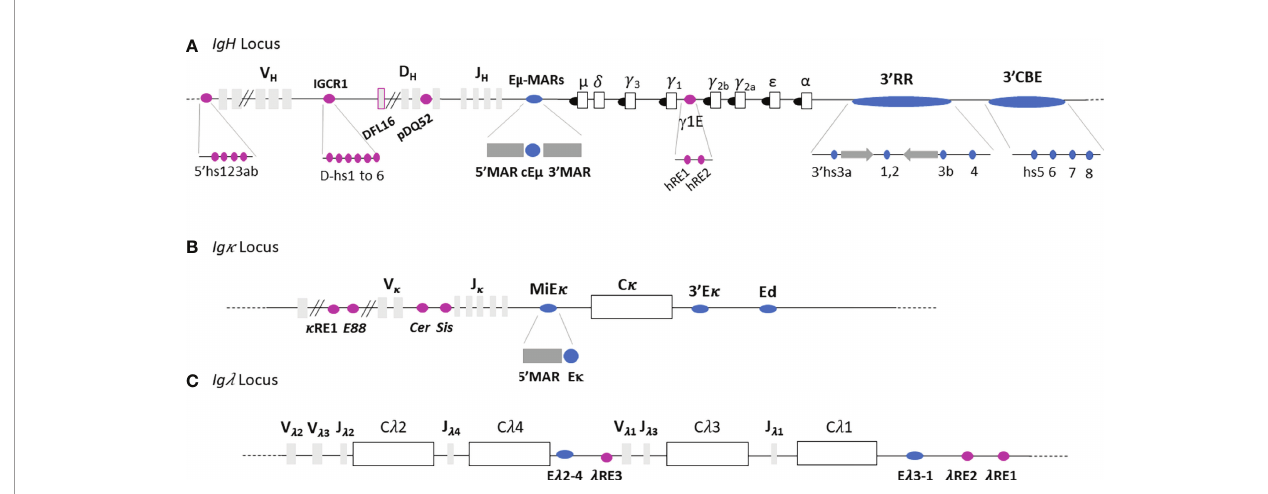
FIGURE 2 | Immunoglobulin loci. (A) IgH locus. (B) Ig k locus. (C) Ig l locus. Light grey and white rectangles represent V, D and J gene segments and constant genes respectively. Black circles represent switch regions and blue and pink ovals represent respectively the main Ig loci regulatory elements and other enhancers. Not to